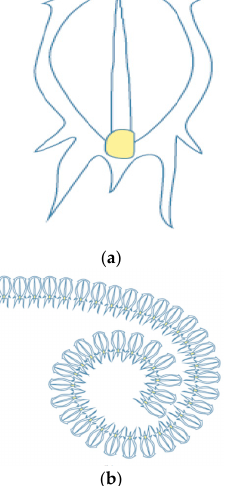
Figure 1. ( a ) Individual Salp, ( b ) Salp chains.